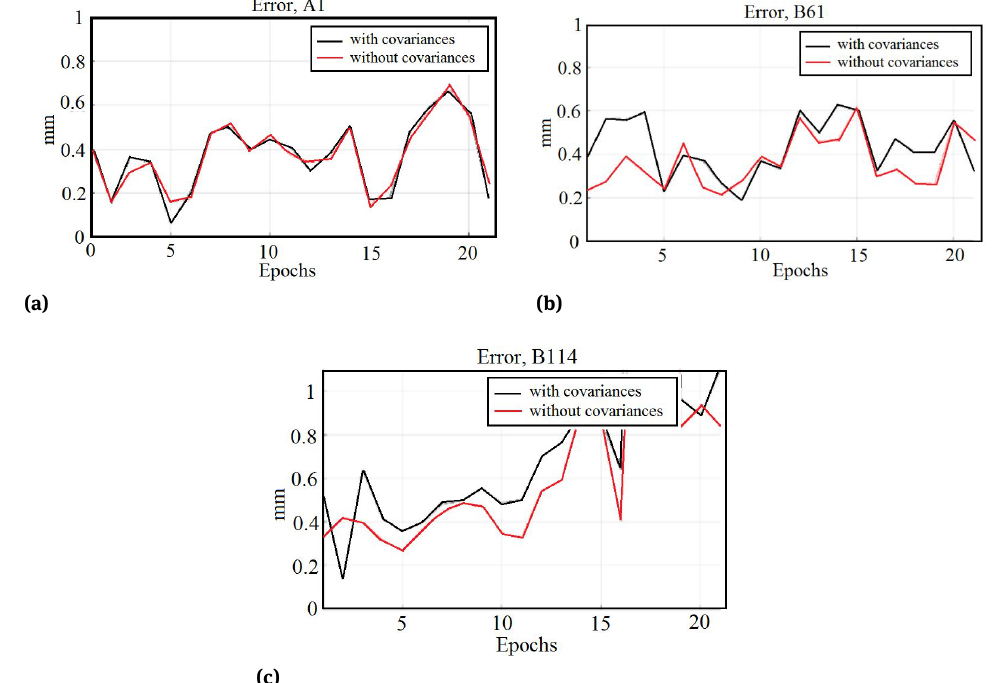
Figure 7: 3D-errors with and without covariances between coordinates at point a) A1, b) B61 and c)